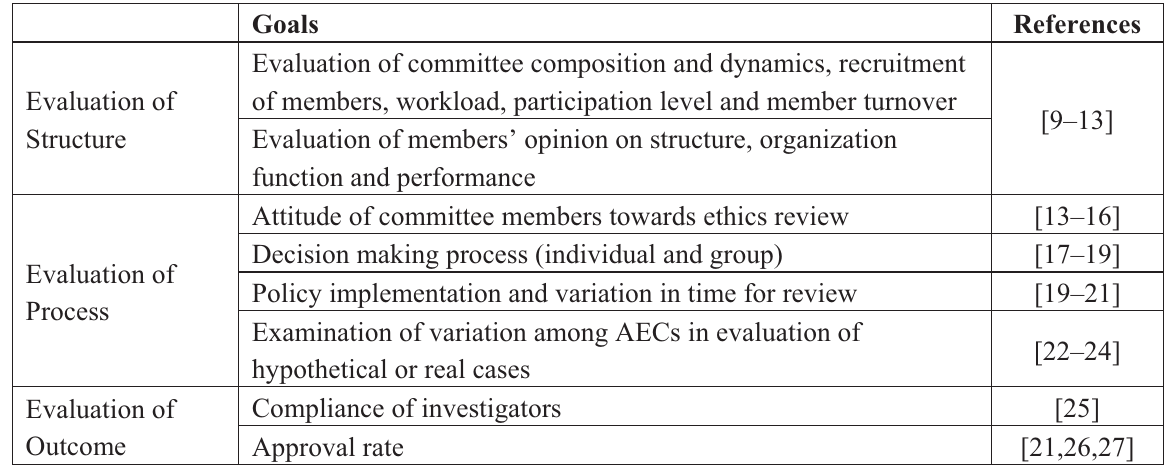
Table 2. Assessment studies, structured according to Donabedian’s model.